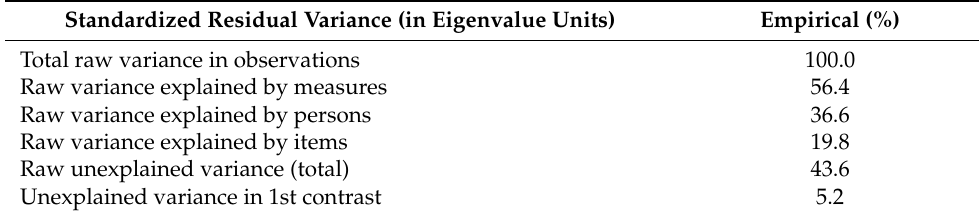
Table 3. Standardized residual variance using Principal Component